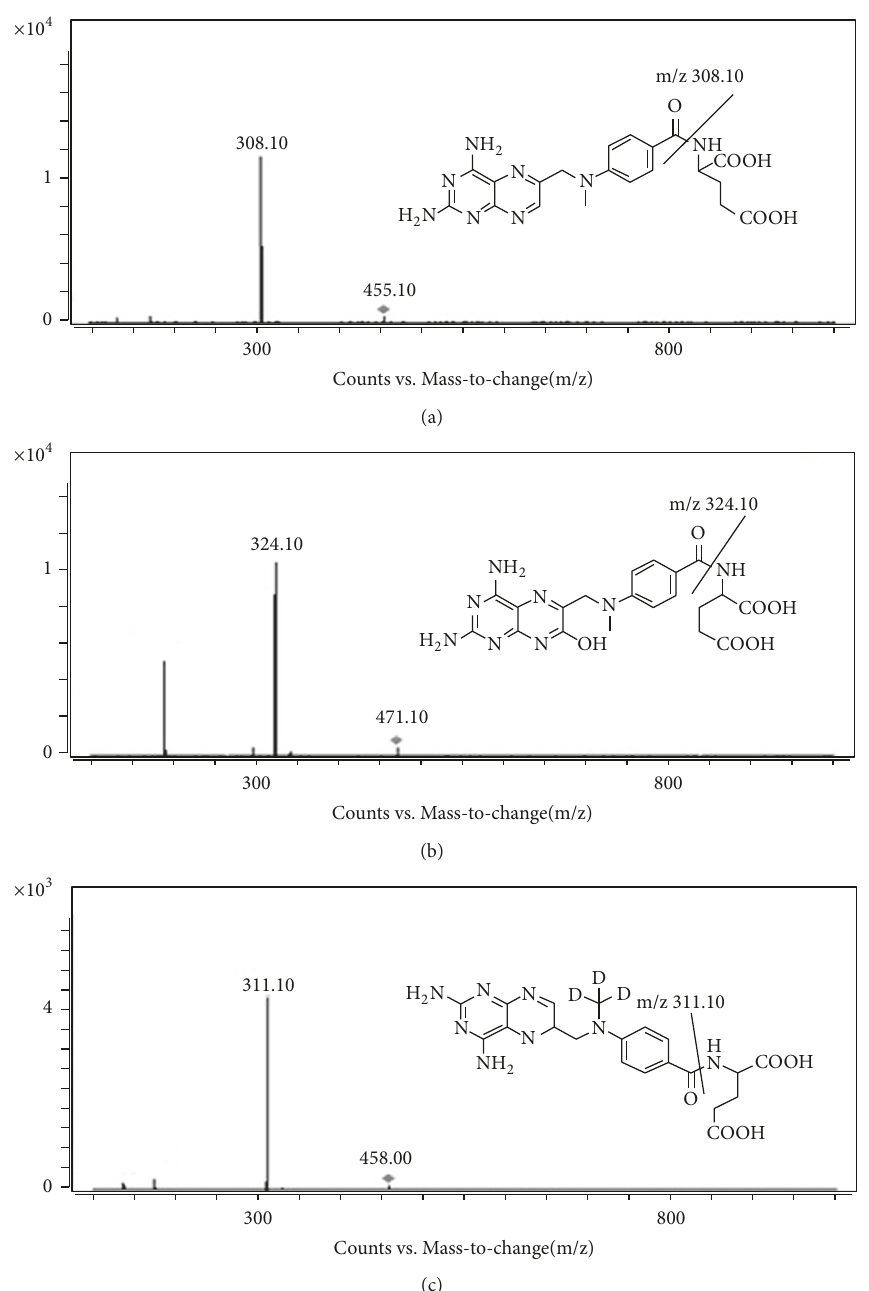
Figure 2: The product ion plots and fragmentor structures of MTX, 7-OH-MTX, and IS in positive mode. (a) MTX; (b) 7-OH-MTX; (c)